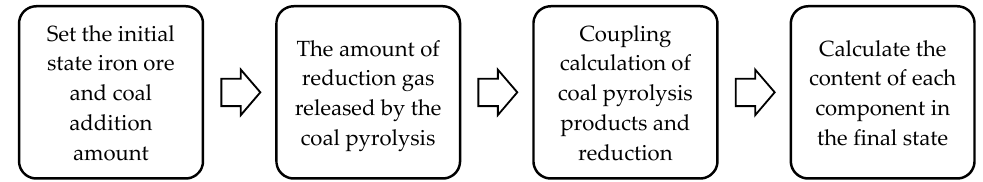
Figure 5. The calculation flow chart of the coupled thermodynamic model.